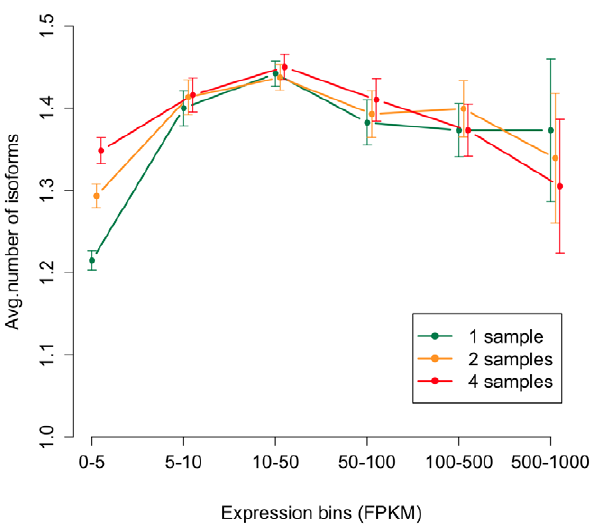
Figure 2. Effect of number of samples and expression intensity on the number of reconstructed isoforms. Isoform reconstruction is performed with TopHat-Cufflinks using one sample (ps94 males), two samples (ps94 males + ps94 females) and all four samples On the x-axis FPKM=Fragments per Kilobase of exon per Million fragments mapped, on the y-axis the average number of reconstructed isoforms is reported. Adding samples increases the amount of predicted isoforms only for low and moderate expression